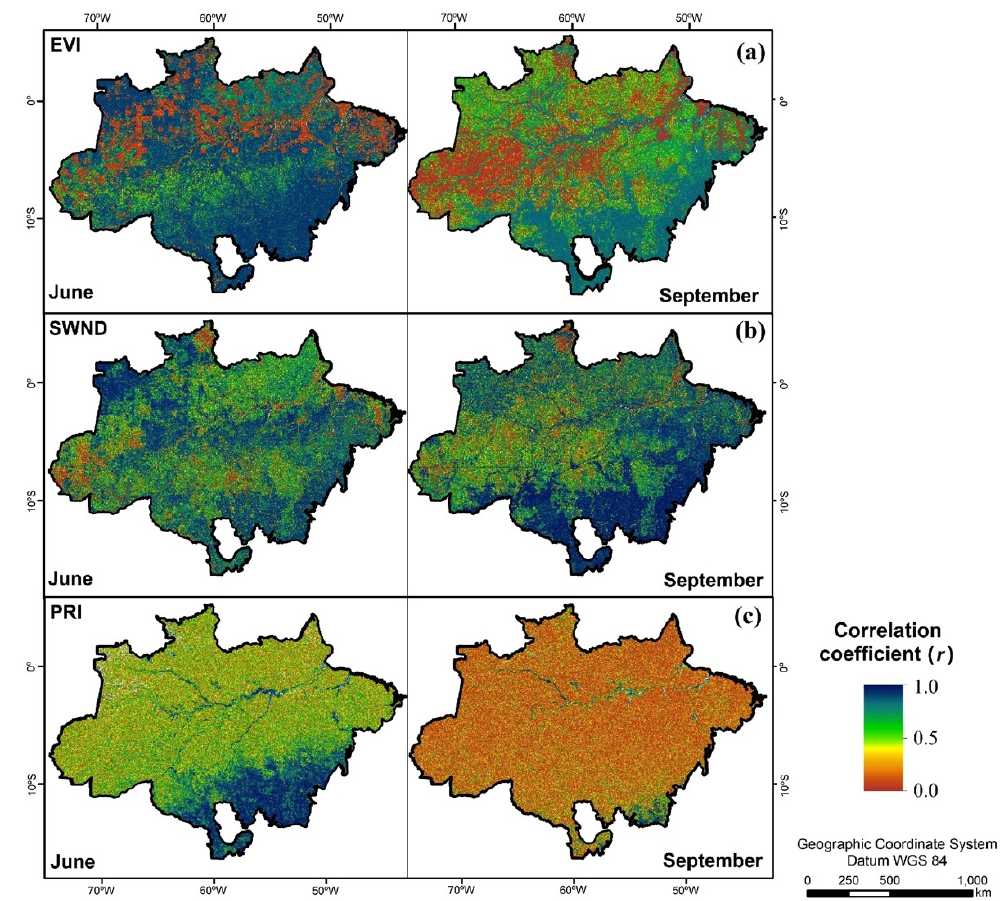
Figure 10. Monthly average Pearson’s correlation coe ffi cients (2000–2014) between BRDF–corrected and non–corrected MODIS ( a ) enhanced vegetation index (EVI), ( b ) shortwave infrared normalized difference (SWND), and ( c ) photochemical reflectance index (PRI) in the beginning (June) and end (September) of the Amazonian dry season.